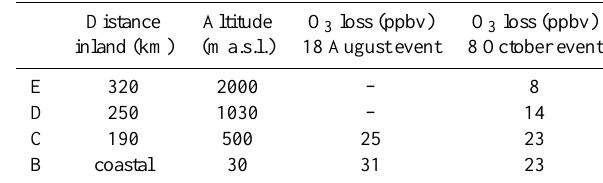
Table 2. The surface ozone anomaly (i.e. difference in mixing ra- tio) during two major ozone depletion events observed at sites on a transect up onto the Antarctic plateau. The anomaly for each site was calculated relative to the 12 h average surface ozone observed at that site before depletion began. For the event of 18 August, data quality did not allow calculation of ozone loss for sites E or D.